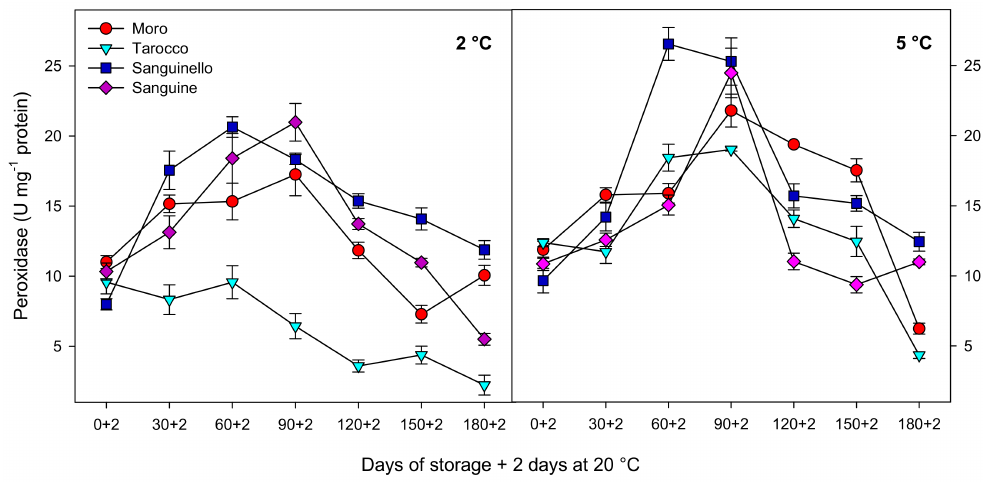
Figure 5. Changes in superoxide dismutase (SOD) and peroxidase (POD) enzyme activities in the flavedo of blood orange cultivars (‘Moro’, ‘Tarocco’, ‘Sanguinello’ and ‘Sanguine’) during cold storage at 2 and 5 ◦ C and 90% relative humidity (RH) plus 2 days at 20 ◦ C. Vertical bars represent ± standard error (SE) of means. LSD ( p < 0.05) value is 0.61 for SOD and 3.12 for